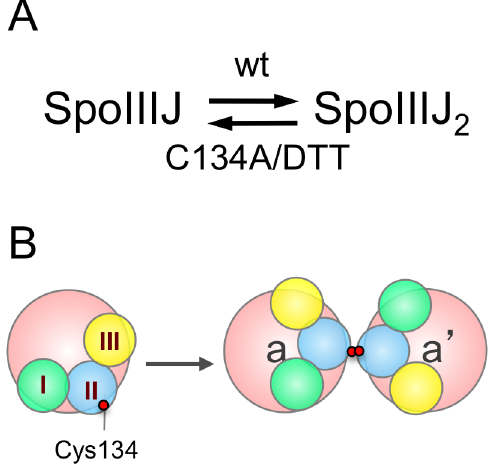
Figure 5. Dimerisation of SpoIIIJ. (A) SpoIIIJ occurs as a monomer and a dimer. The dimer is thought to be stabilised by a disulphide bond involving residue Cys134. However, this residue is not essential for dimer formation. (B) A disulphide bond between cysteine residues (red circles), along with other interactions promotes the formation and/or maintenance of the dimeric form of SpoIIIJ. TM segments 1, 2 and 3 are depicted as green, blue, and yellow circles, respectively. doi:10.1371/journal.pone.0099811.g005 PLOS ONE |